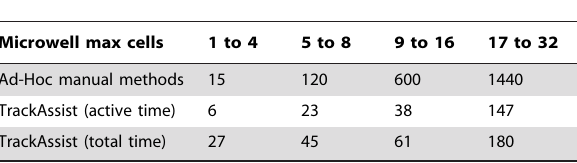
Table 1. Comparison of labour required (in minutes) to track all cells in a microwell and extract lineage, using either ad-hoc manual methods (such as spreadsheets, Matlab etc.) or the TrackAssist